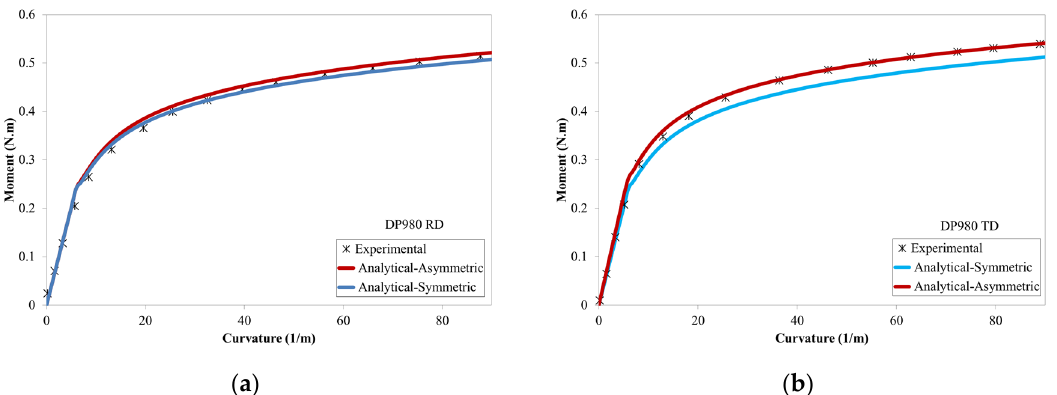
Figure 5. Comparisons of bending moment–curvature diagrams of DP980 under pure bending in the ( a ) rolling direction and ( b ) transverse direction. ( a ) rolling direction and ( b ) transverse direction.